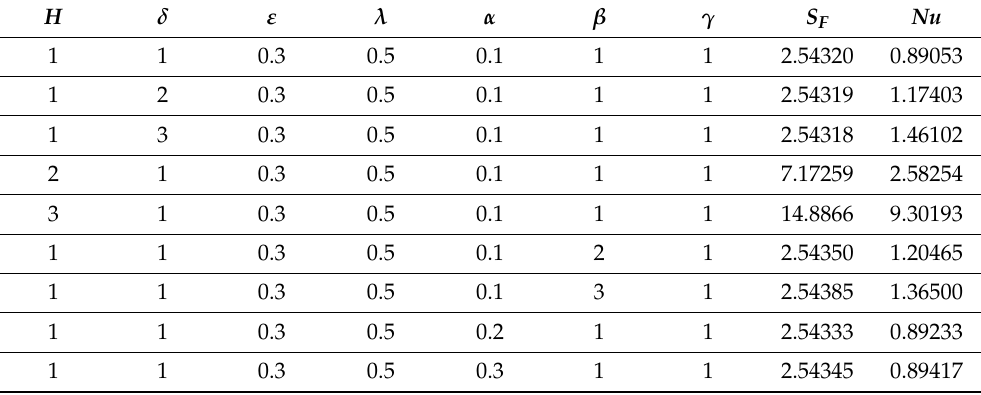
Table 4. Skin Friction and Nusselt number for various fluid parameters.